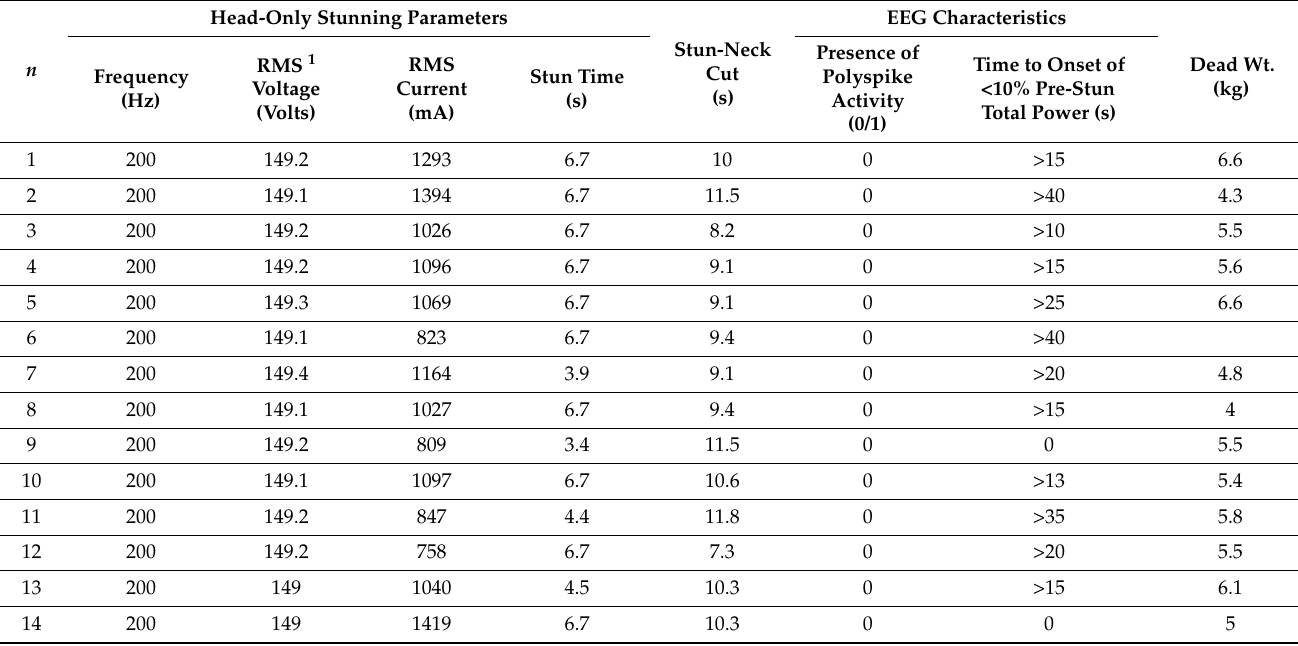
Table 6. The effect of head-only stunning followed by slaughter on the electroencephalogram (EEG) in turkeys. Head-Only Stunning Parameters n